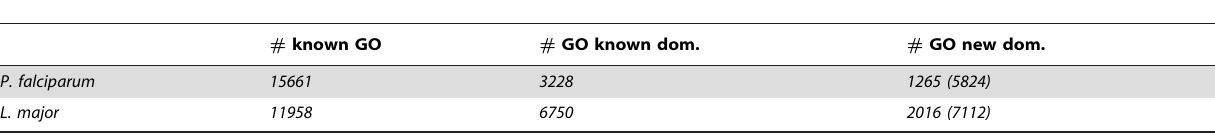
Table 3. New GO annotations at 5%